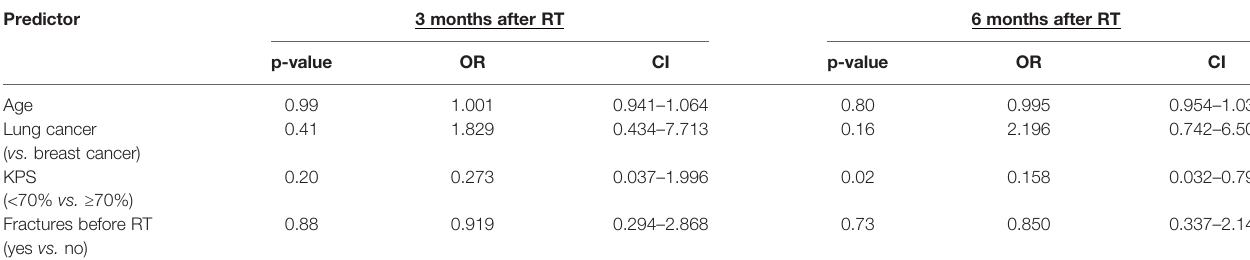
TABLE 3A | Univariate analysis of prognostic factors related to stabilization of initially unstable SBM according to SINS. Predictor 3 months after RT 6 months after RT